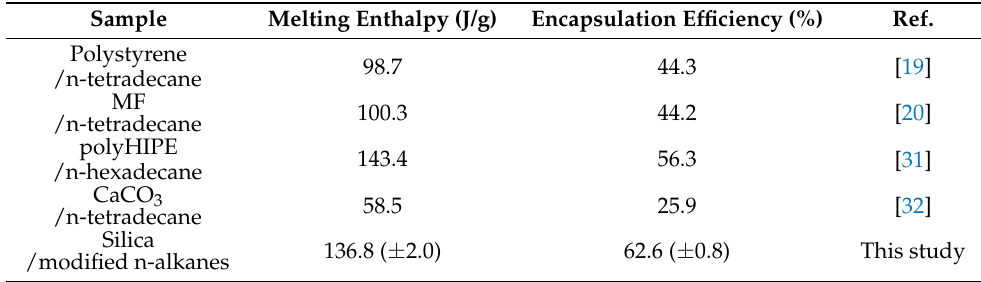
Table 2. The comparison of encapsulation efficiency of different PCMs.